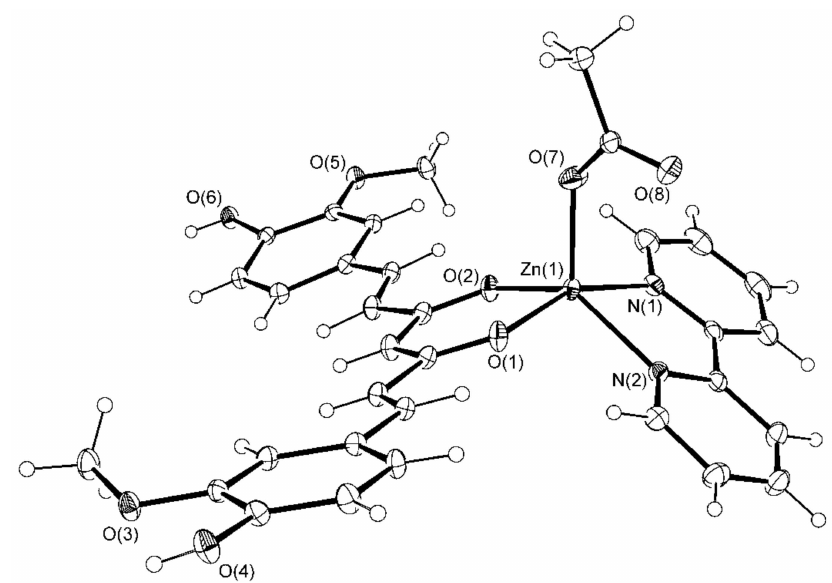
Figure 1. ORTEP drawing of [Zn(CH 3 COO)(cur)(bpy)]( 1 ) with displacement ellipsoids drawn at the 30% probability level.